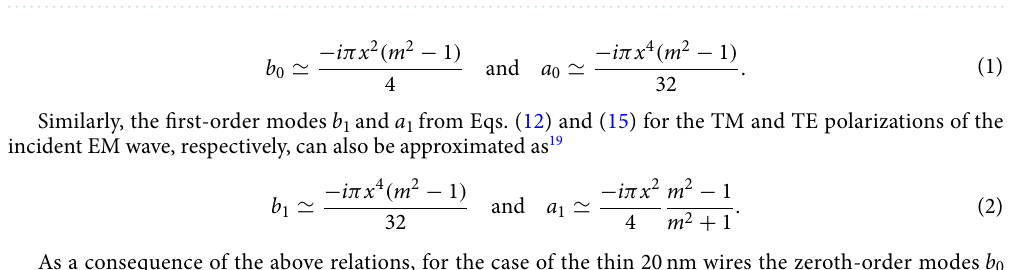
Figure 4. Mie absorption efficiency ( Q absPer ) for the TE ( E ) polarization of the incident radiation with zeroth ⊥ (blue), first (red) and second (green) order contributions as a function of the wavelength (cid:31) for ( a , d , g , j ) Au 20, 80, 140 and 200 nm respectively, at (DL model), ( b , e , h , k ) Si and ( c , f , i , l ) GaAs nanowires of radii r = 200 (solid lines) and 650 (dotted lines) K . The thick orange and pink solid lines represent temperatures T = 200 and 650 K , respectively. Here, the Mie the total absorption efficiencies, Q absPer , at temperatures T = computations for the nanowires of different sizes take into account their thermal expansion, although the text labels indicate the values for nanowire radii at 200 K . Also see Tables S4–S6 b in the Supporting Information for a summary of the spectral positions of the resonances, the contributing orders to the absorption resonances and the numeric values of the absorption efficiencies for the TE ( E ) ⊥